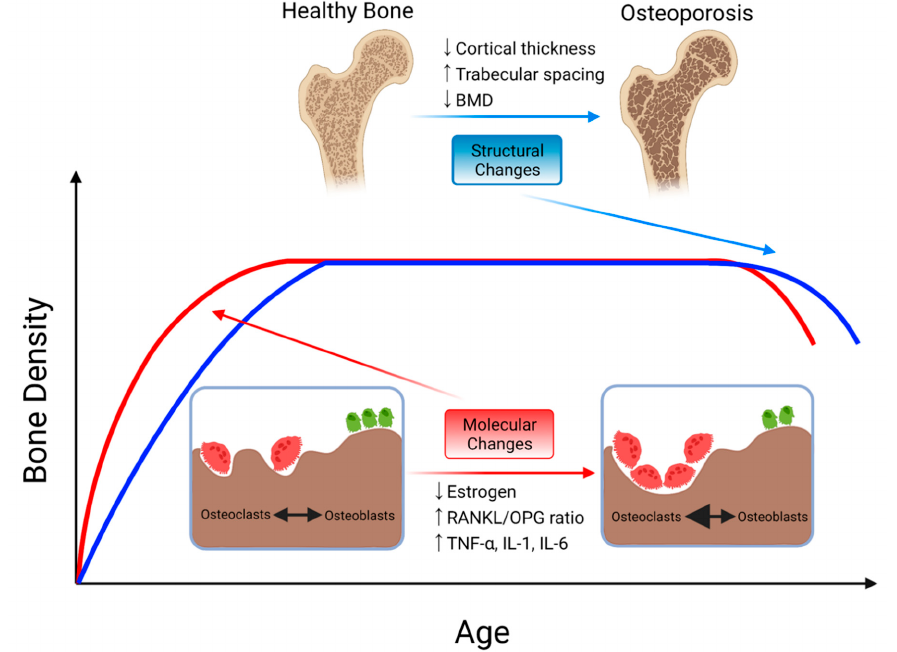
Figure 1. Schematic graph and representation of changes in bone disease with aging in osteoporosis. Molecular changes that favor bone resorption over bone formation such as decreased estrogen, increased RANKL/OPG ratio, and increased inflammatory cytokines such as TNF- α , IL-1, and IL-6 precede structural changes in the bone. Structural changes associated with osteoporotic bone include decreased cortical thickness, increased trabecular spacing, and decreased bone mass density.